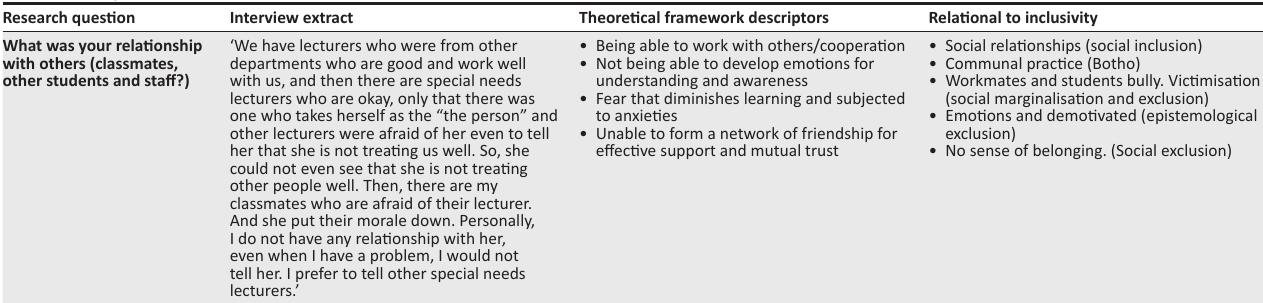
TABLE 1 : Examples of how themes were created. Research question Interview